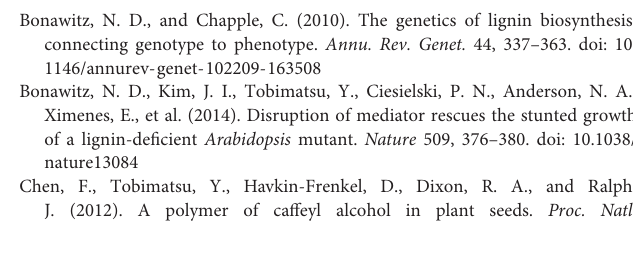
Supplementary Table 1 | Primers used in RT-PCR and qRT-PCR analyses. Supplementary Table 2 | Proteins in SDS-PAGE gel blocks identified by mass